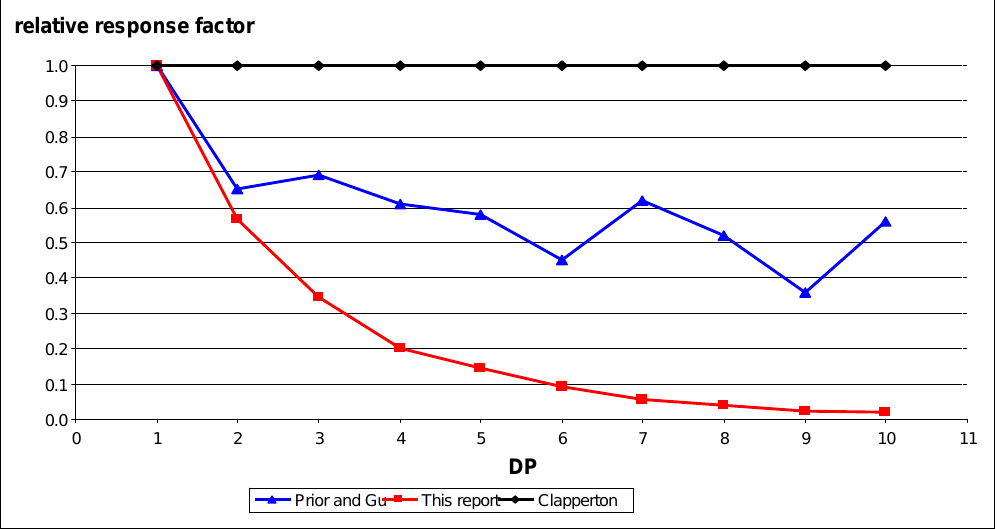
Figure 4 . Relative Response Factors (RRF) for Three Standard Types.